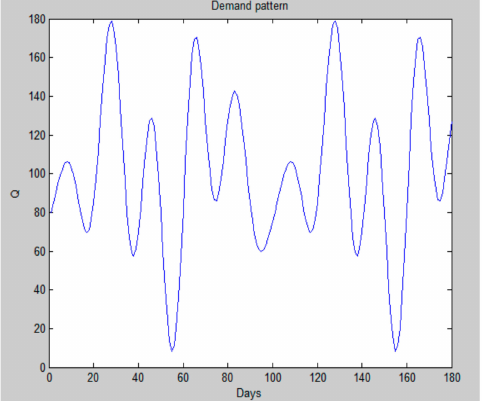
Figure 4. The demand pattern for